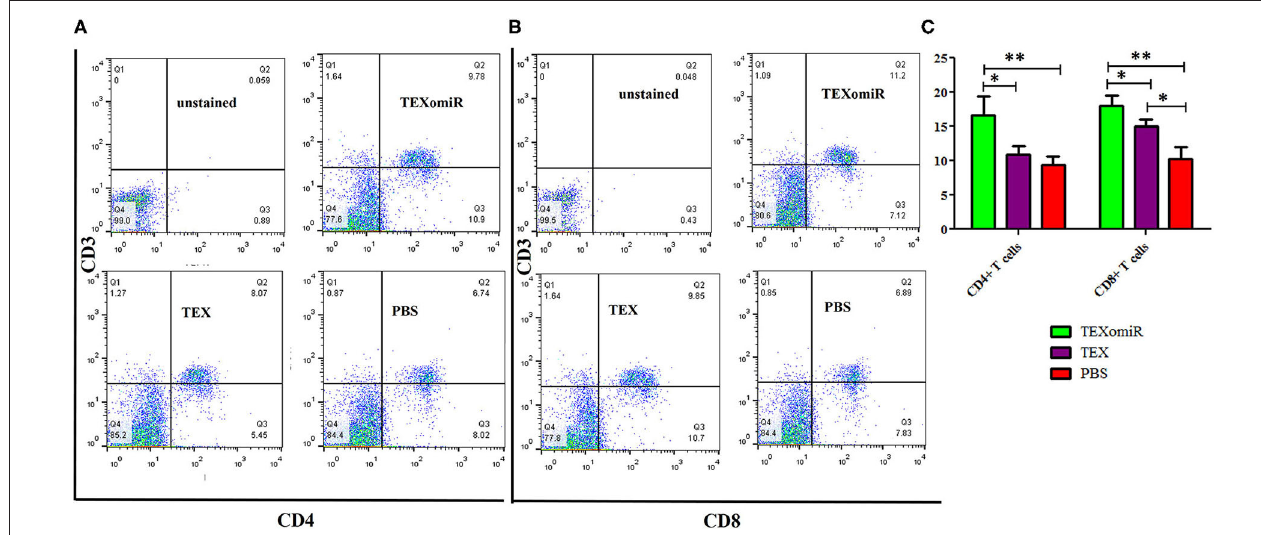
FIGURE 7 | The effect of TEXomiR on lymph node lymphocytes. (A,B) Flow cytometry analysis of CD4 T + and CD8 T + lymphocytes in lymph node from CT-26 tumor-bearing mice treated with TEXomiR, TEXs, and phosphate-buffered saline (PBS). (C) A significant increase in the number of CD8 + and CD4 + T lymphocytes was detected in the TEXomiR group compared with the PBS group. The data are presented as mean ± SD. ** P < 0.01, * P < 0.05. One-way ANOVA was used to make comparisons between groups. TEXomiR, miR-124-3p-enriched TEXs; TEX, tumor